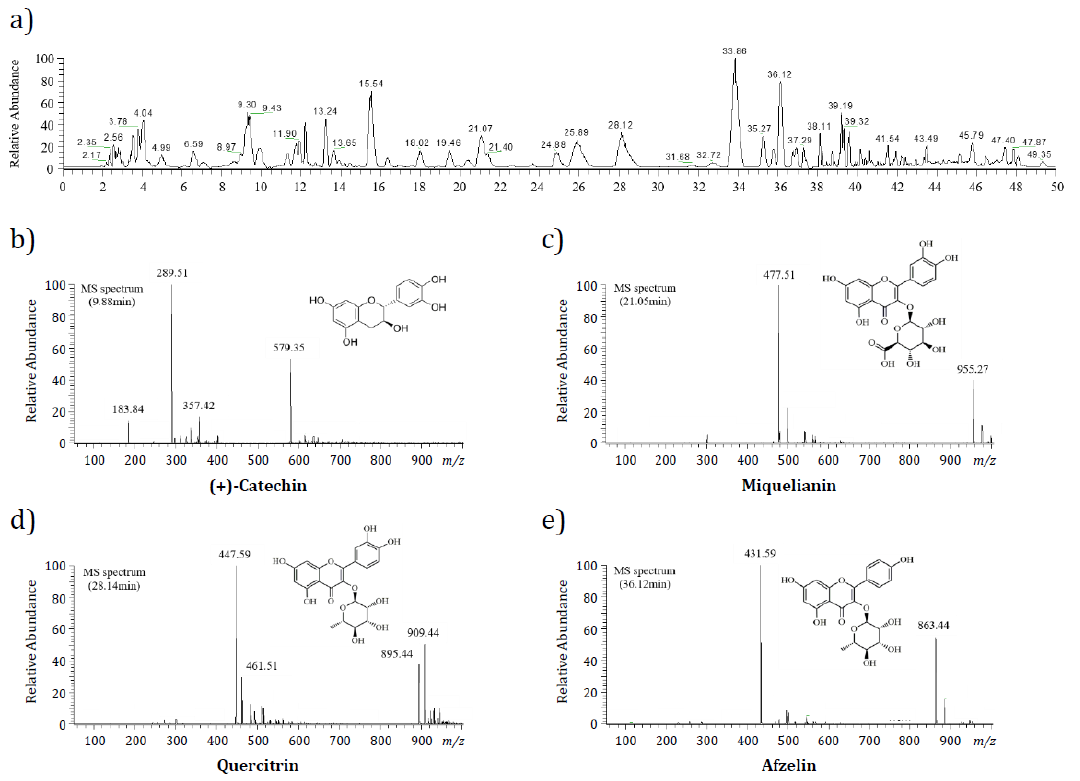
Figure 5. UHPLC-MS chromatogram and mass spectrum of Filipendula glaberrima Nakai extract. ( a ) Total ion chromatogram. ( b – e ) Mass spectra of the peaks at 9.88 min, 21.05 min, 28.14 min, and 36.12 min on the total ion chromatogram. A 30 mg/mL of FGE was introduced to UHPLC-MS for analysis.